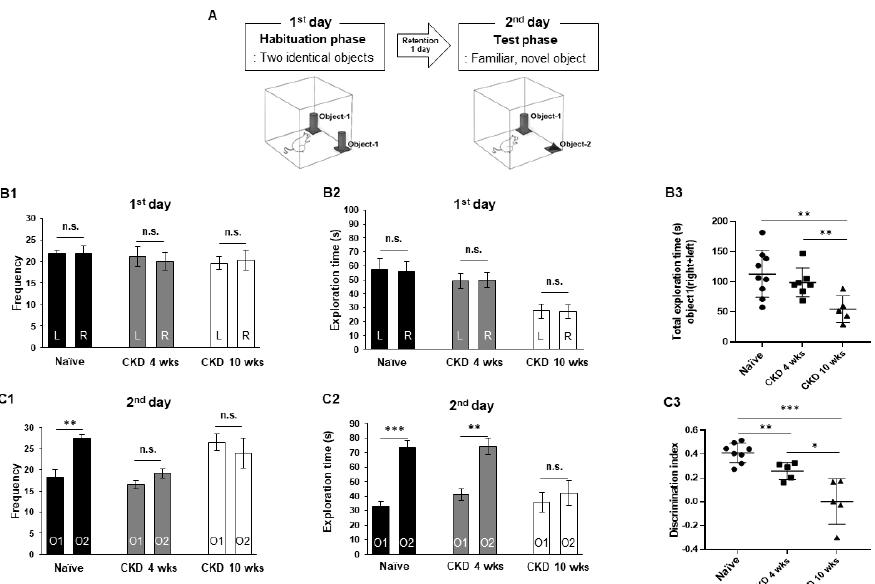
Figure 1. Decreased novel object recognition memory in CKD model rats. Schema of the novel object recognition test ( A ). In the habituation period, the frequency of searching for familiar and novel objects was similar in naïve and CKD 4, 10- wk rats ( B1 ). The exploration time for familiar and novel objects was similar in both naïve and CKD rats ( B2 ). However, the object exploration times were markedly decreased in CKD 10-wk rats compared with naïve rats ( B3 ). Naïve rats showed significantly increased frequency and times for novel objects ( C1 , C2 ). CKD 4-wk rats showed novelty preferences in exploration times ( C2 ). However, CKD 10-wk rats did not show preferences for novel objects ( C1 , C2 ). In particular, the discrimination index of CKD rats for new objects was notably different as time passed after surgery ( C3 ). L, left side; R, right side; O1, object-1; O2, object-2. Data are presented as means ± standard errors of the mean. n.s.: not significant, * p < 0.05, ** p < 0.01, *** p < 0.001 by one-way analysis of variance naïve: n = 8; CKD 4 wks: n = 7; CKD 10 wks: n = 5.